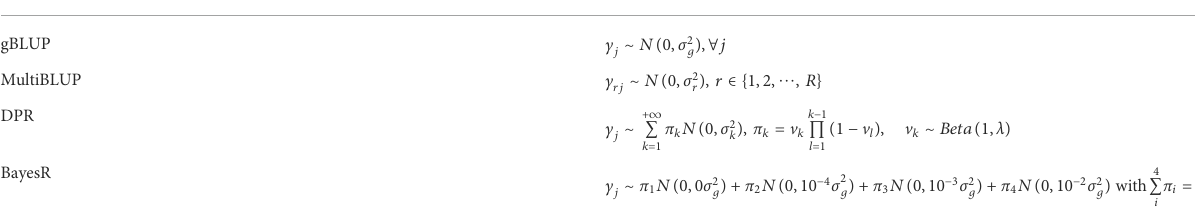
TABLE 1 The prior distributions of random effects under different methods. Methods Effect size